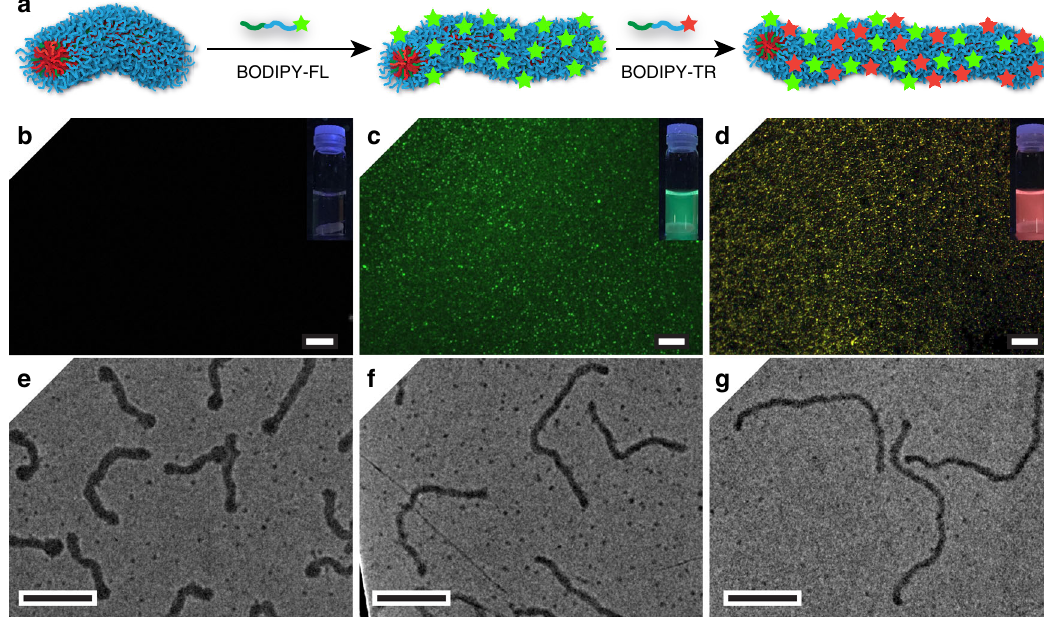
Fig. 4 Controlled fabrication of fl uorescent anisotropic nanoparticles by MORPH. a Non- fl uorescent seed worms with A:T molar ratio 0.33 were converted into green and then yellow fl uorescent nanoparticles by adding BODIPY-FL ( PA G ) and -TR ( PA R ) tagged polymers sequentially. b – d Confocal fl uorescence images (overlay of green and red channels, scale bars = 10 μ m) with photographs of the nanoparticle solutions under UV light as insets. e – g Stain-free TEM images con fi rming the controlled morphological transformation (scale bars = 200